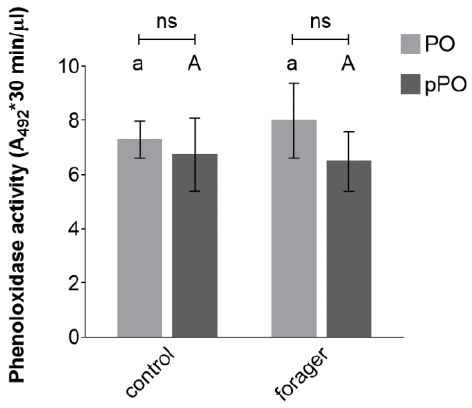
Figure 5. The constitutive phenoloxidase activity (PO) and total phenoloxidase activity measured after enzymatic cleavage of prophenoloxidase (pPO) in cell-free hemolymph of non-foraging control and foraging Bombus terrestris ( n = 3; six animals per biological replicate which means 18 bumble bee workers per each group). The enzymatic reaction was measured for 30 min and PO activity expressed as integral of absorbance per µ L of hemolymph. Data presented as mean ± SD; significant di ff erences p < 0.05 between control and forager group are indicated by di ff erent small and capital letters above the columns for PO and pPO, respectively ( t -test); ns = not significant di ff erence between PO and pPO assay ( t